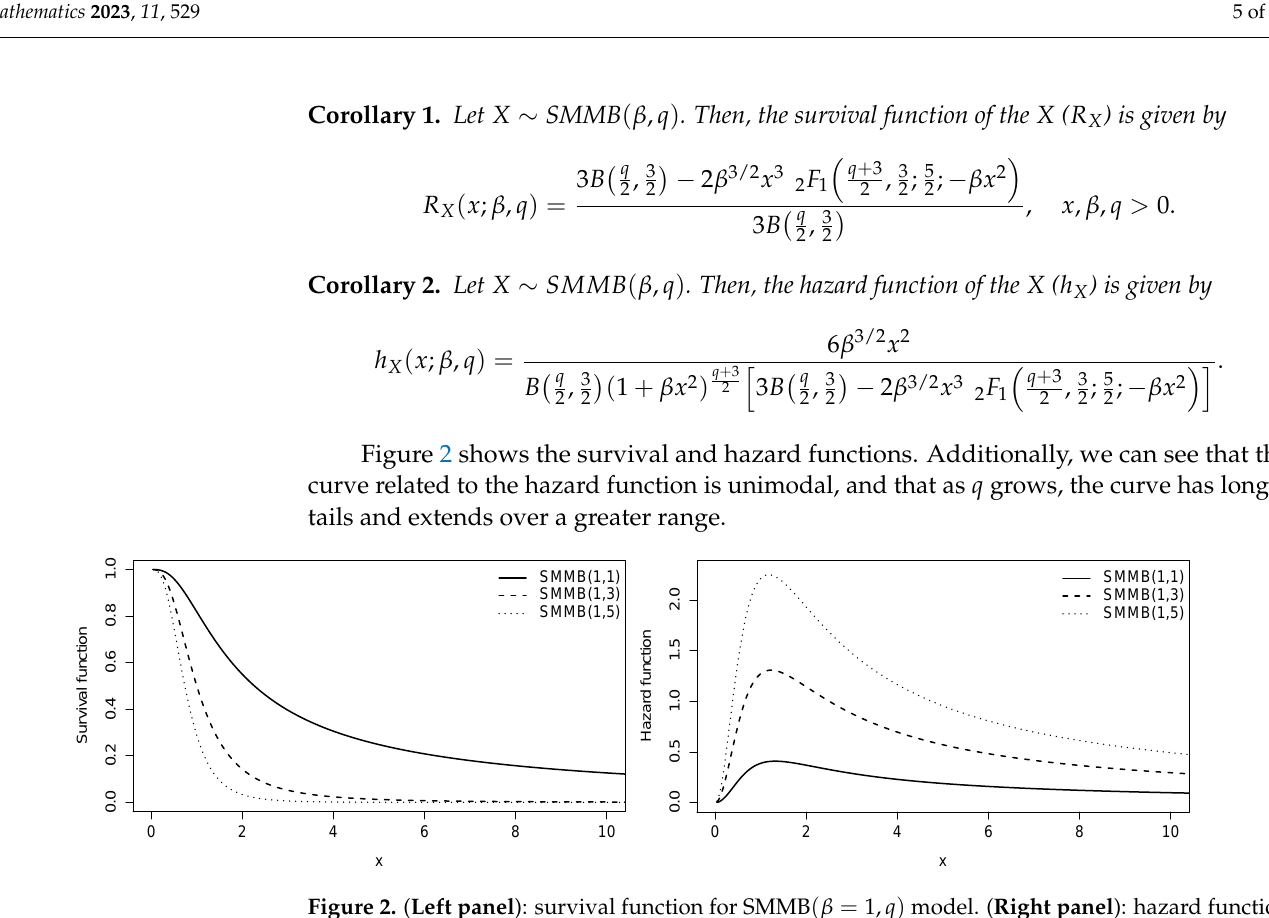
Figure 2. ( Left panel ): survival function for SMMB ( β = 1, q ) model. ( Right panel ): hazard function for SMMB ( β = 1, q ) model. In both cases, different values for q were